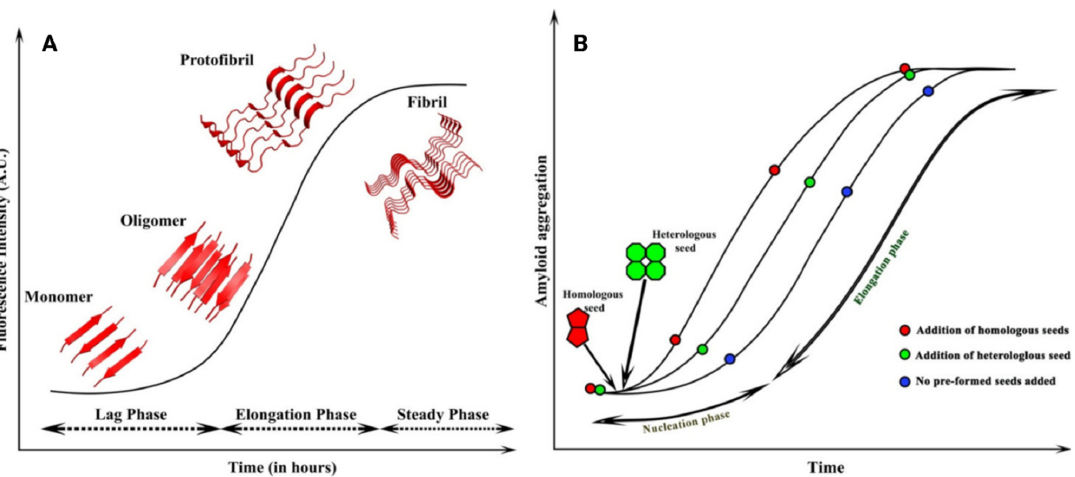
Figure 2. Schematic representation of amyloidogenic cascade and amyloid seeding. ( A ) The sigmoidal curves exhibit different forms because monomers, oligomers, protofibrils, and fibrils are formed at various phases depending on time. ( B ) Amyloid seeding: the addition of pre-formed seeds reduces the lag phase, leading to faster aggregation. Homologous seeds, which have the same nature as the existing nuclei, lead to homologous seeding, whereas the heterologous seeds differ from the initial nuclei and lead to heterologous or cross-seeding. Modified with permission from Subedi S. et al., 2022